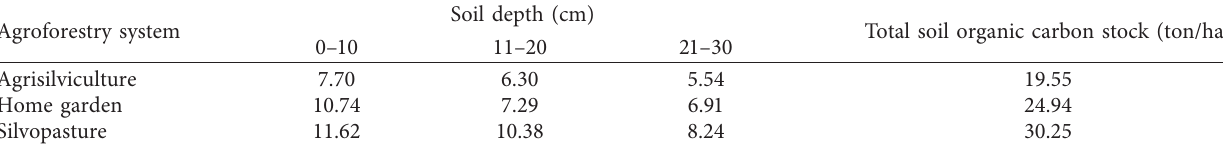
Table 4: Total soil organic carbon stock (ton/ha) at various depths and agroforestry systems. Soil depth Agroforestry system